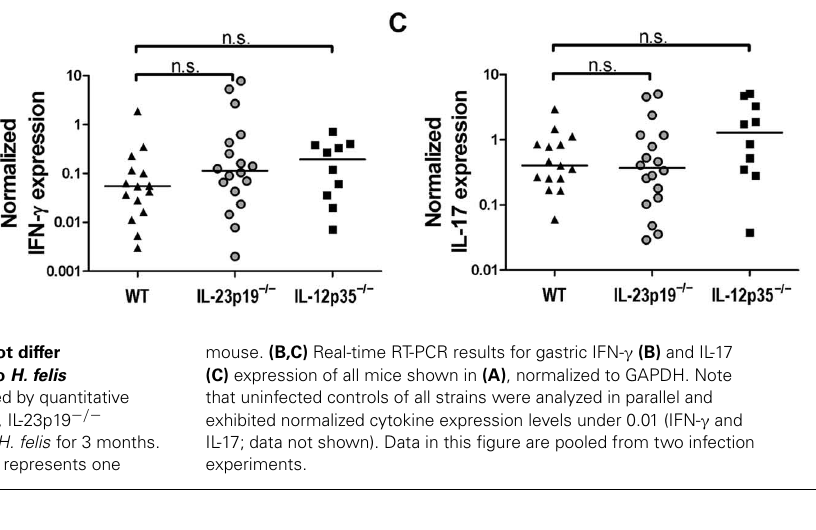
mouse. (B,C) Real-time RT-PCR results for gastric IFN- γ (B) and IL-17 (C) expression of all mice shown in (A) , normalized to GAPDH. Note that uninfected controls of all strains were analyzed in parallel and exhibited normalized cytokine expression levels under 0.01 (IFN- γ and IL-17; data not shown). Data in this figure are pooled from two infection